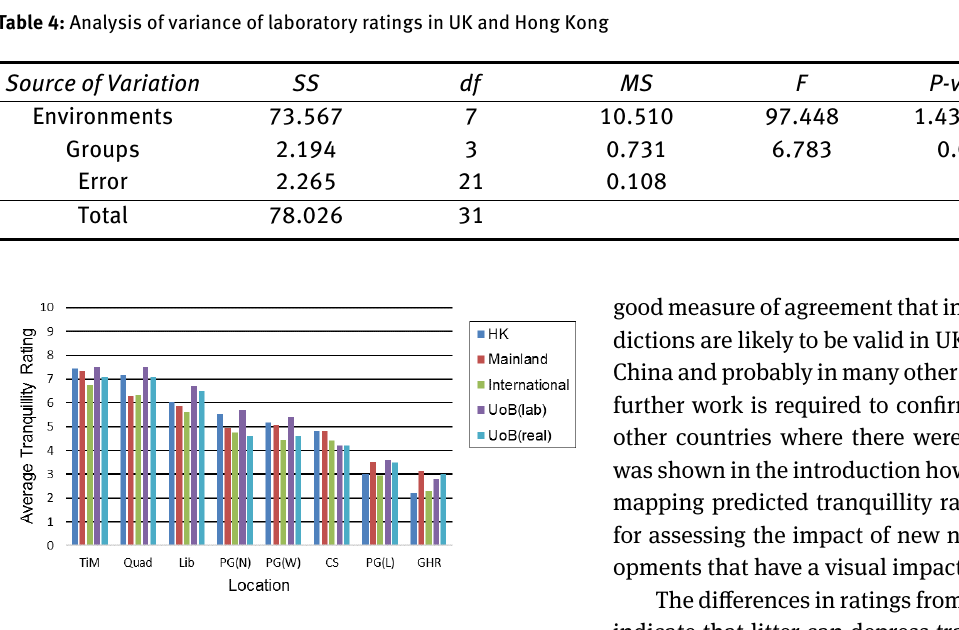
Figure 6: Comparison of average tranquillity ratings by subject groups and